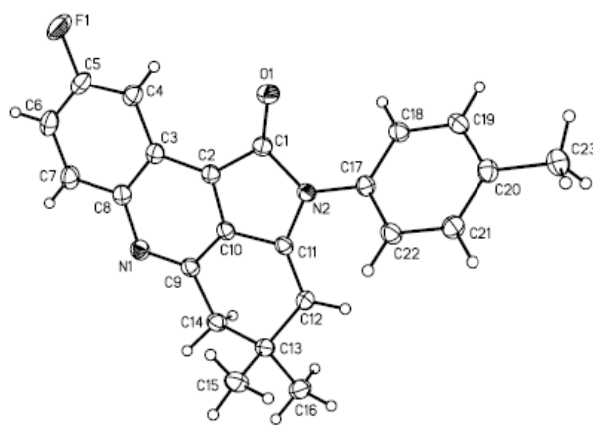
Figure 1. Molecular structure of compound 3k